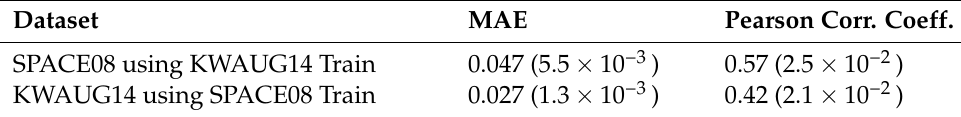
Table 6. Convolutional neural network transfer learning regression